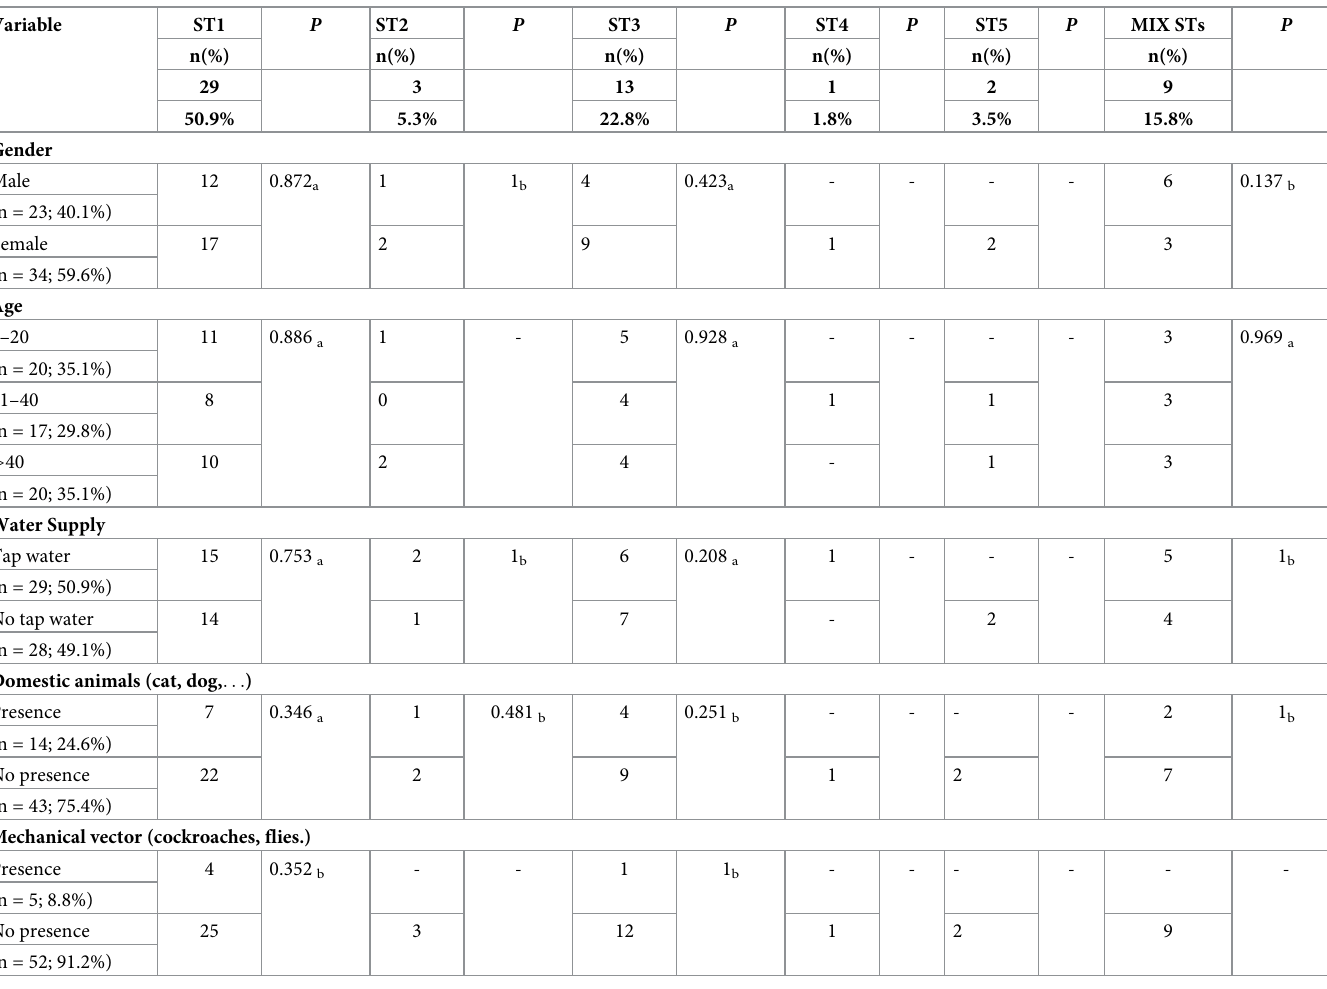
Table 4. Association between Blastocystis subtypes and the studied